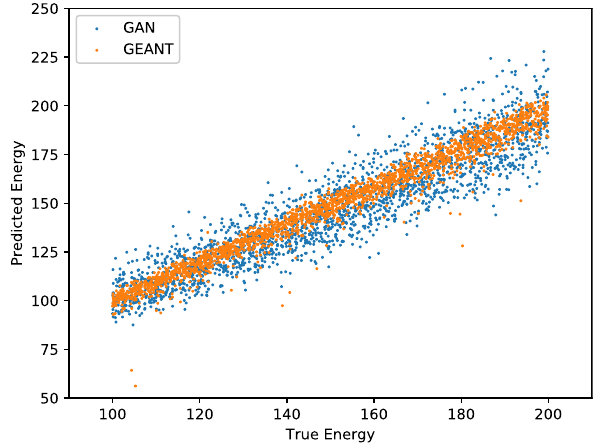
Fig. 21 Predicted vs. true particle energy for GAN and GEANT images. Predictions were made using the reconstruction tool described in Sect. 5. This plot was made using 2213 electron events of each type (GAN and